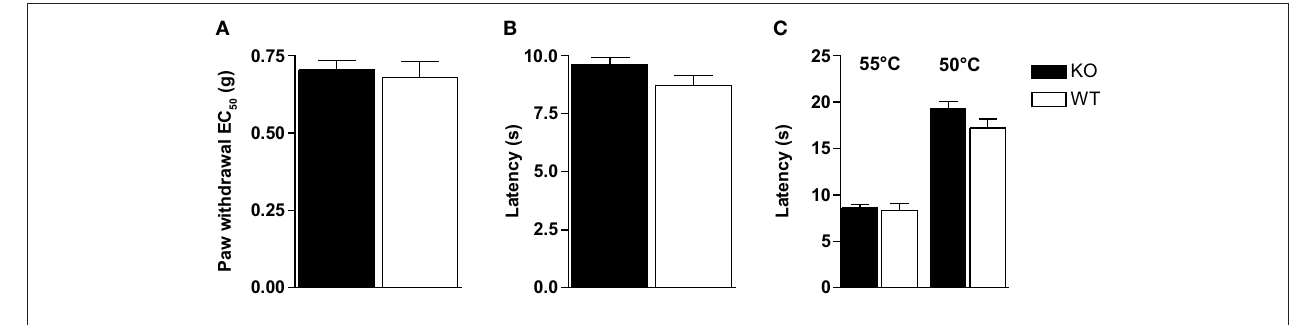
FIGURE 1 | Glra3 − / − mice show no differences in their acute pain behaviours. (A) Punctate mechanical stimulation using calibrated von Frey ( Glra3 − / − , n = 16; wild type, n = 10). Thermal stimulation using either (B) the